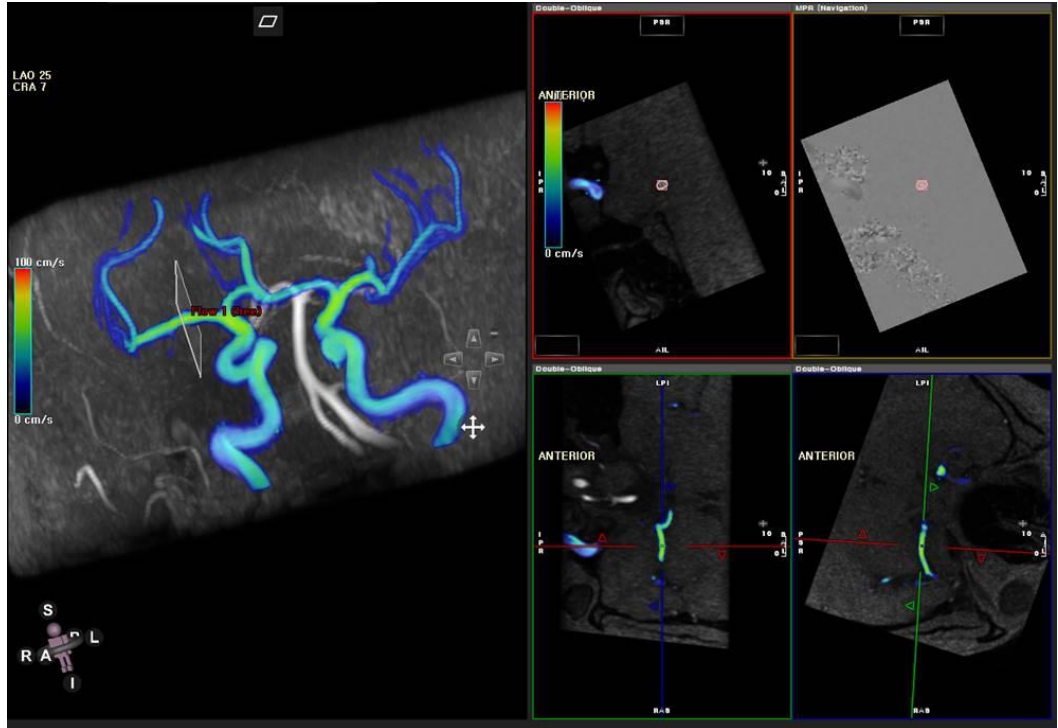
Figure 1. A representative image to set an analysis plane at right mid-M1 segment perpendicular to the vessel direction using commercial software. the vessel direction using commercial